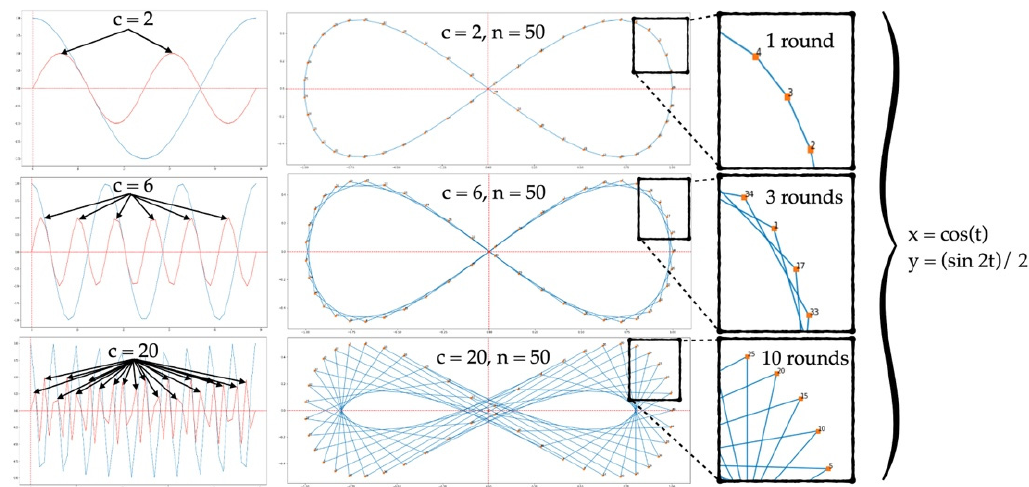
Figure 7. Illustration of infinity shapes.